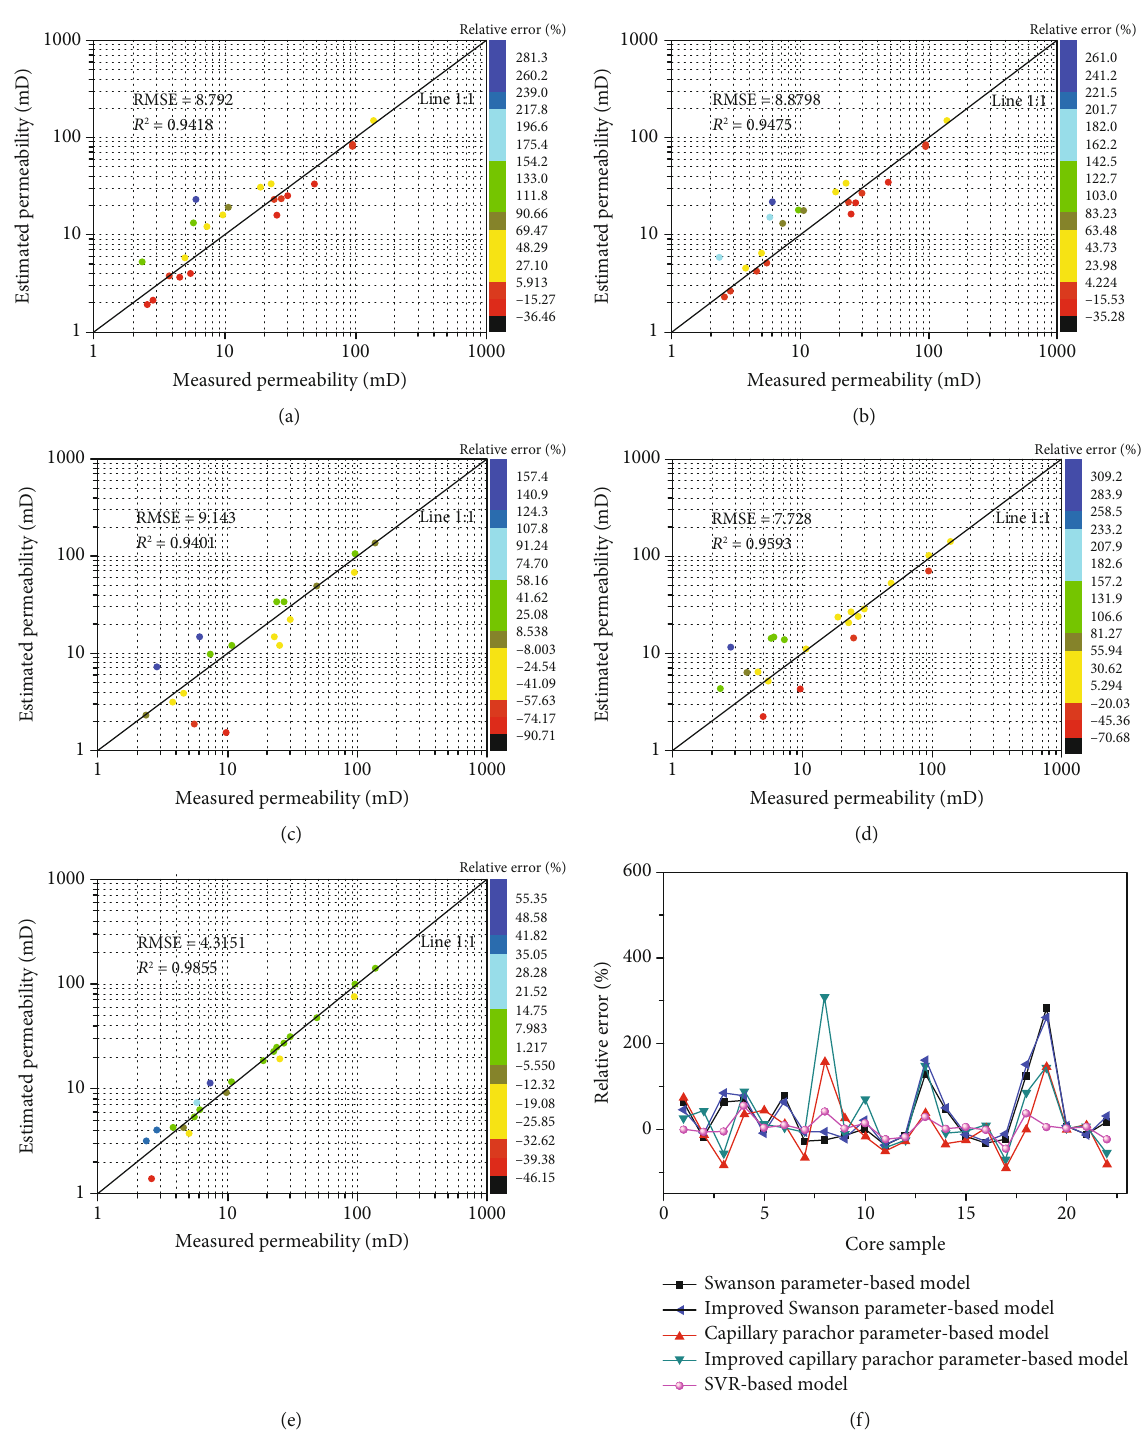
Figure 8: Comparison of the permeability prediction results and measurements of the 22 core samples: (a) Swanson parameter-based model results; (b) improved Swanson parameter-based model results; (c) capillary parachor parameter-based model results; (d) improved capillary parachor parameter-based model results; (e) SVR model results; (f) relative error of all models. The results indicate a notable match between the SVR model predicted and the measured